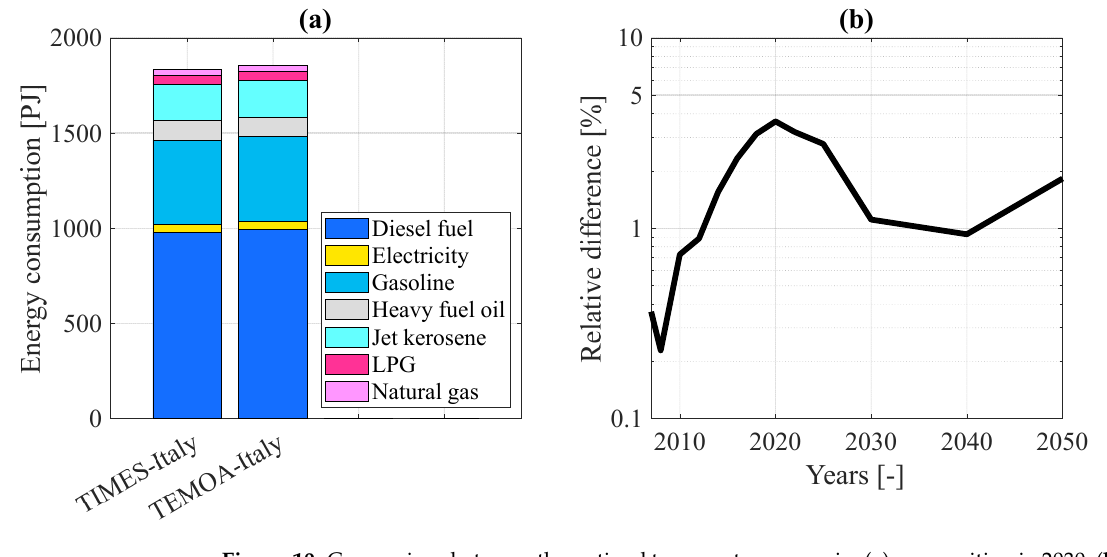
Figure 10. Comparison between the optimal transport energy mix: ( a ) composition in 2030; ( b ) average relative difference curve along the time.